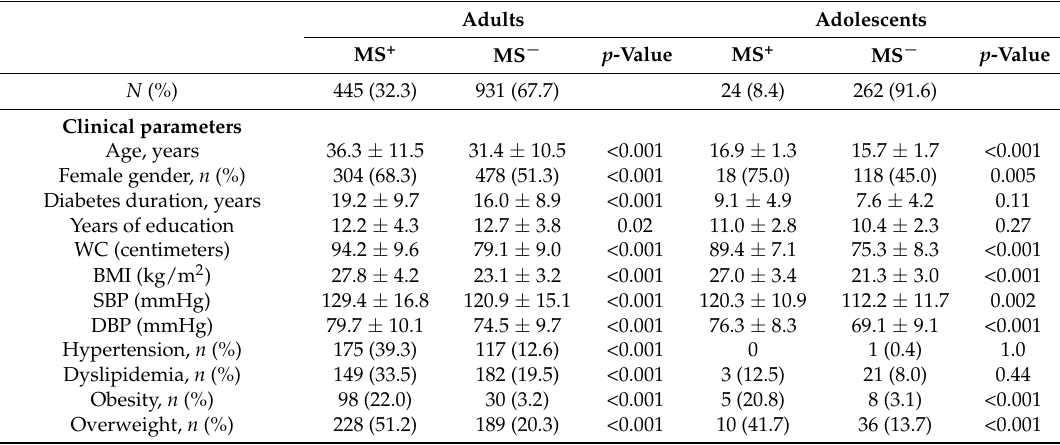
Table 1. Comparison of clinical and laboratorial parameters between groups with and without metabolic syndrome, stratified by age